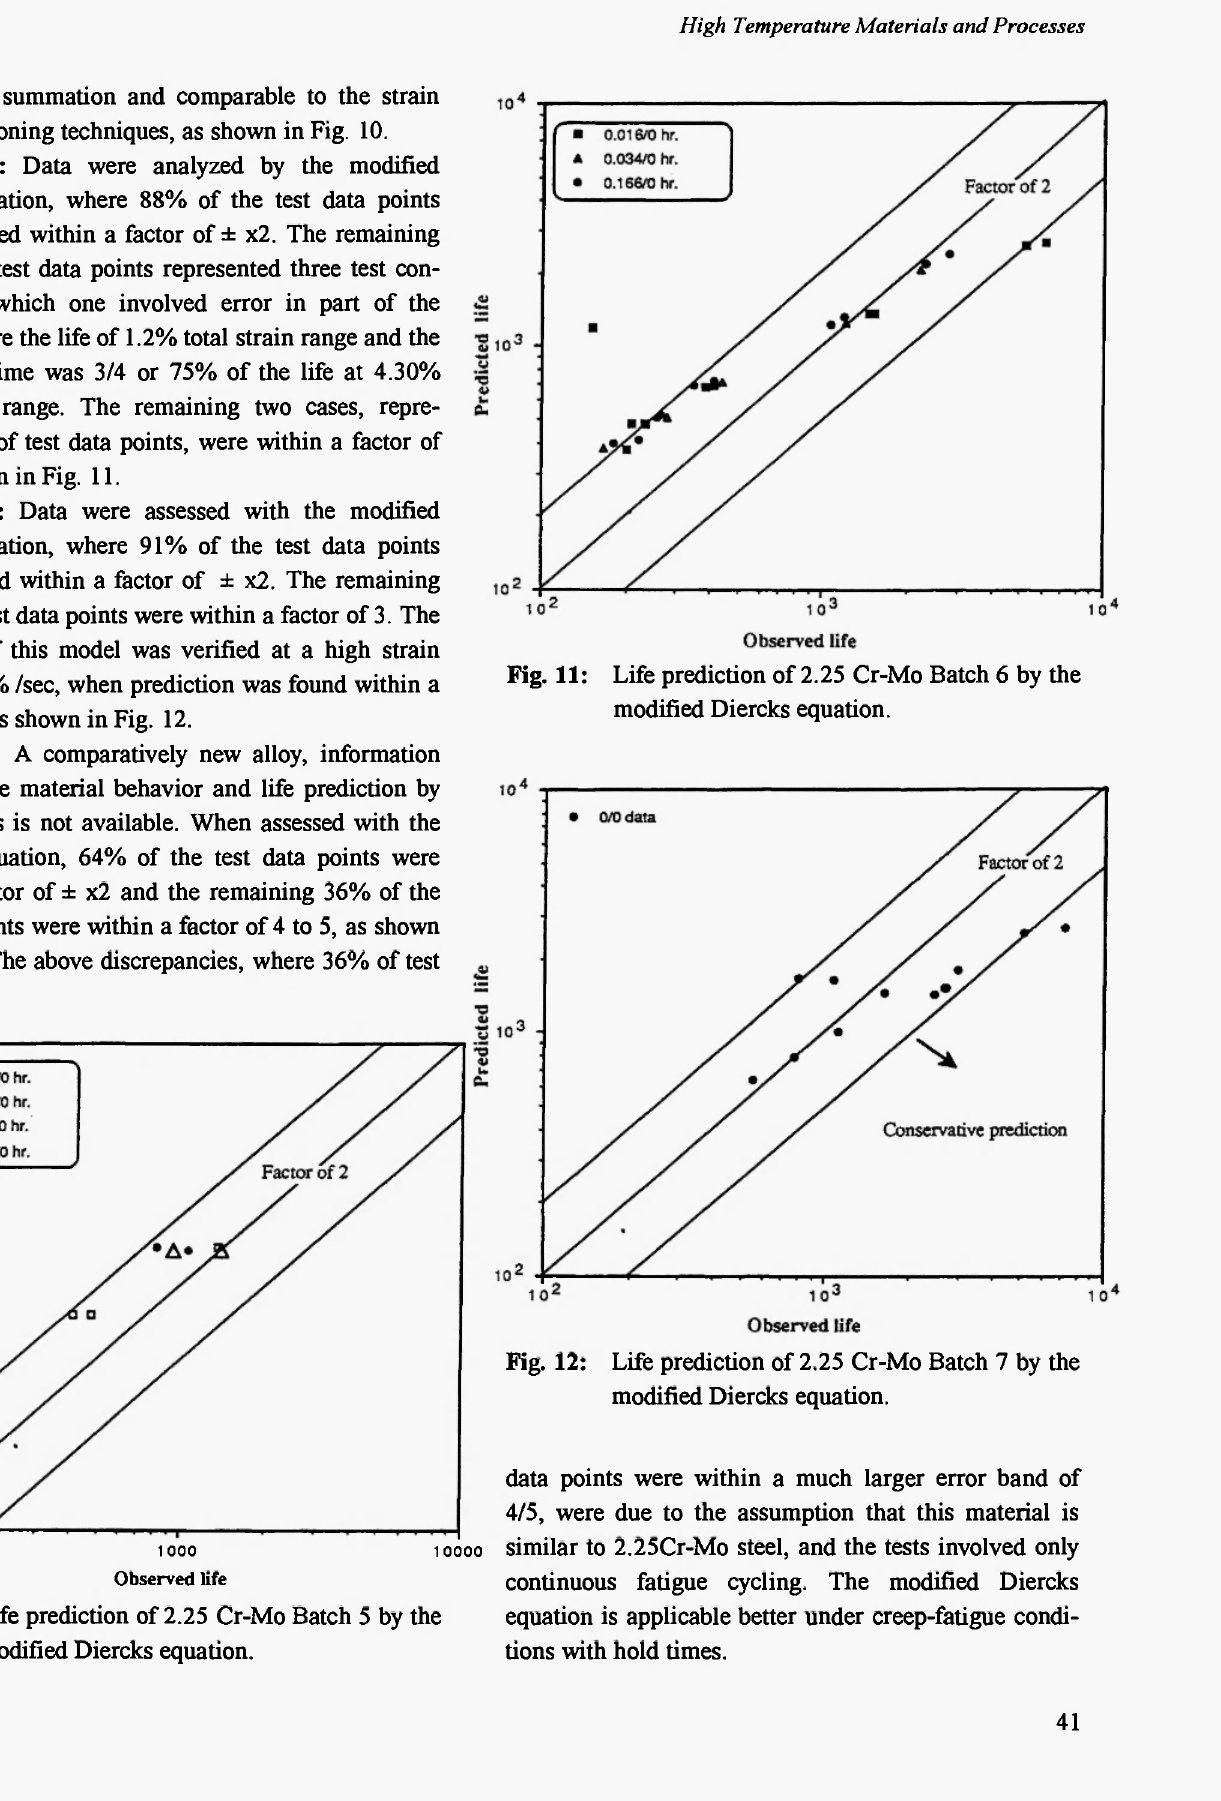
Fig. 12: Life prediction of 2.25 Cr-Mo Batch 7 by the modified Diercks equation. data points were within a much larger error band of 4/5, were due to the assumption that this material is similar to 2.25Cr-Mo steel, and the tests involved only continuous fatigue cycling. The modified Diercks equation is applicable better under creep-fatigue condi- tions with hold